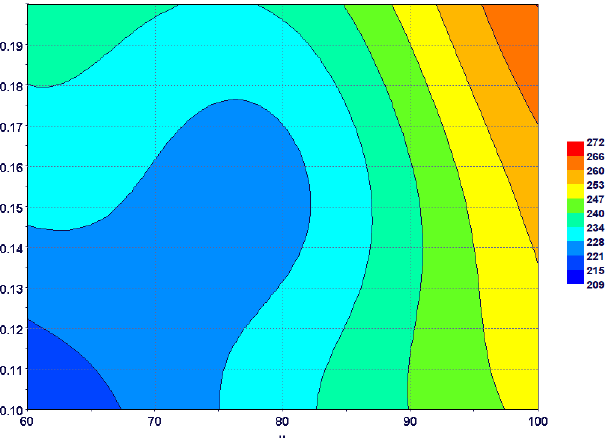
Figure 11. Combined effect of cutting speed and feed rate on maximum tool temperature.